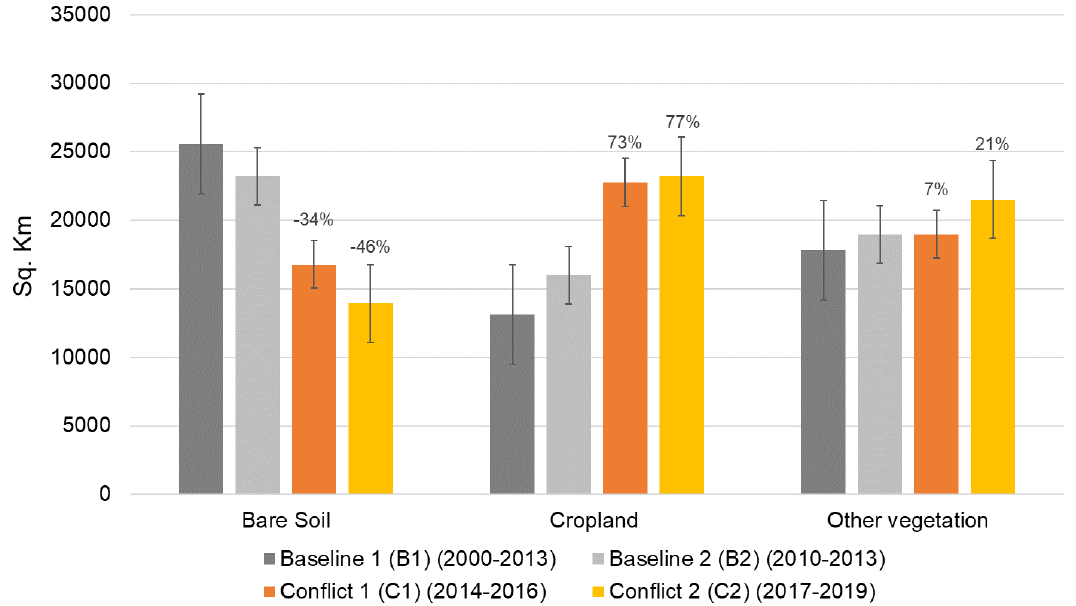
Figure 3. Changes in average LULC extent between the baseline periods and the conflict periods. Labels with percentages indicate the areal change from the long baseline period (B1) to the corresponding conflict period (C1 or C2). The error bars denote the standard error of each change.